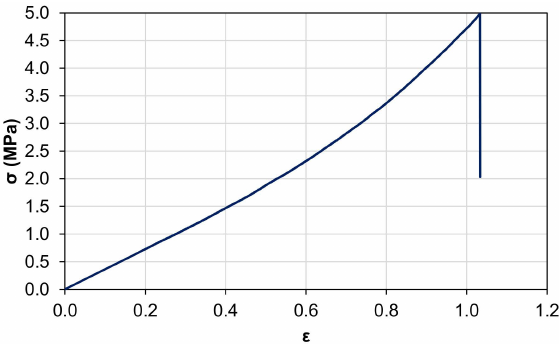
Figure 15. Stress vs. strain of the polymeric matrix of the developed sensor.